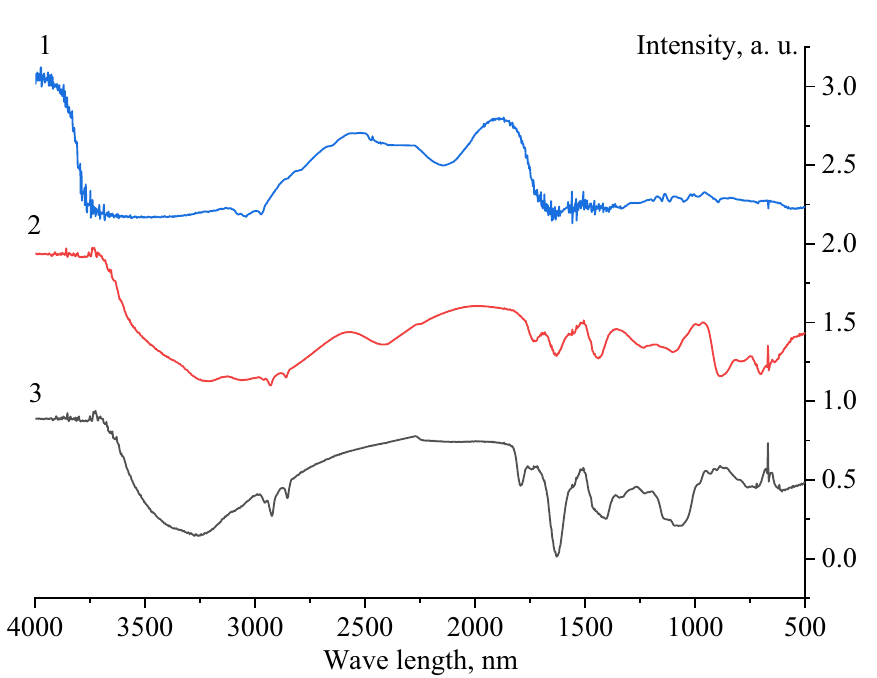
Figure 5. IR spectra of Se NPs samples: 1 – CAPB, 2 – the negative Se NPs sol, 3 – the positive Se NPs